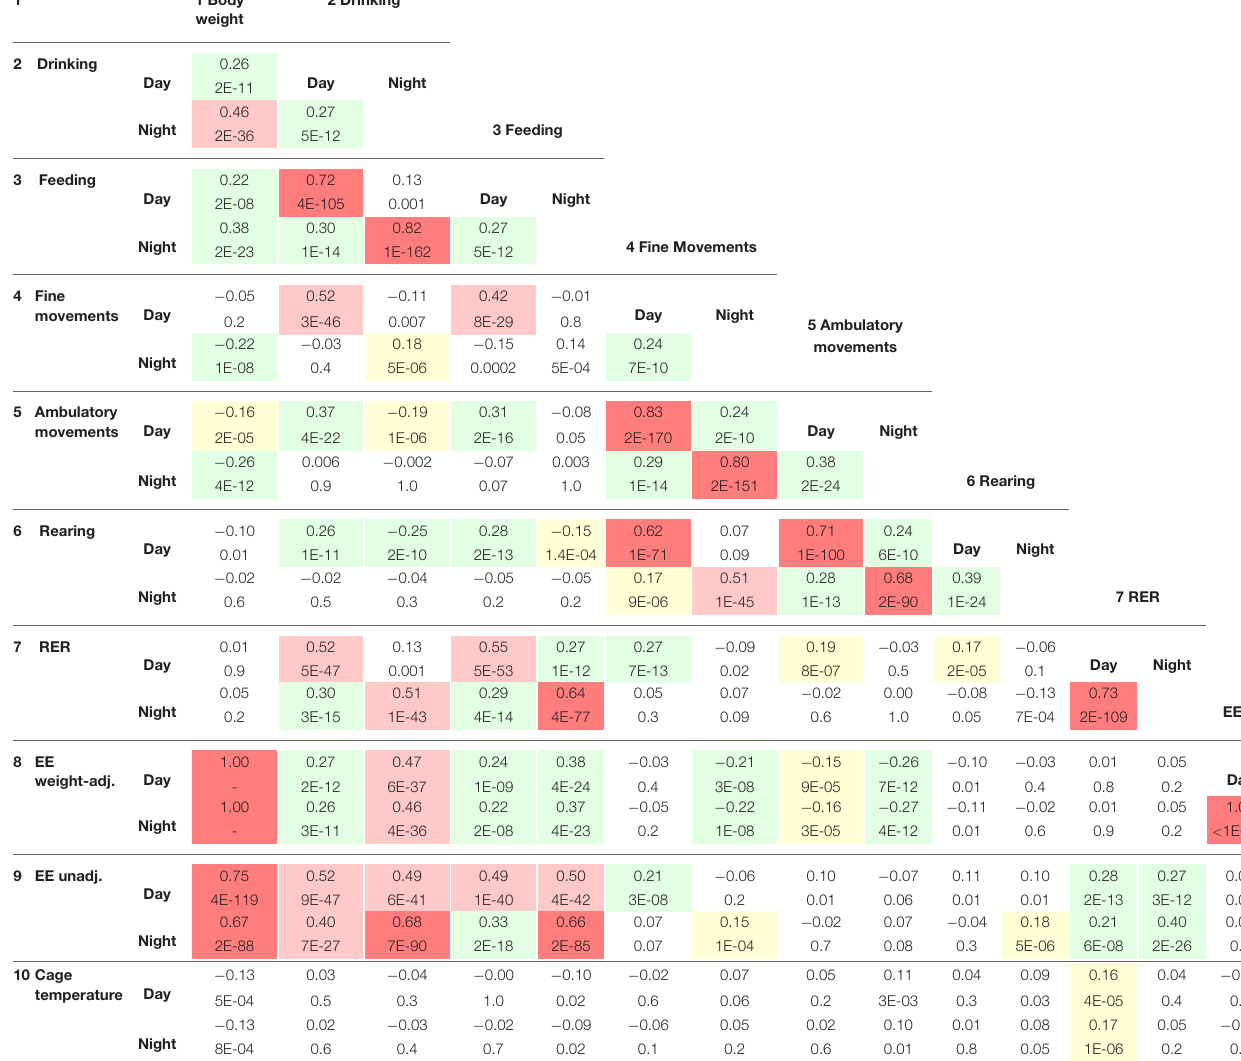
TABLE 4 | Correlations among the traits based on collapsed-strain and collapsed-sex